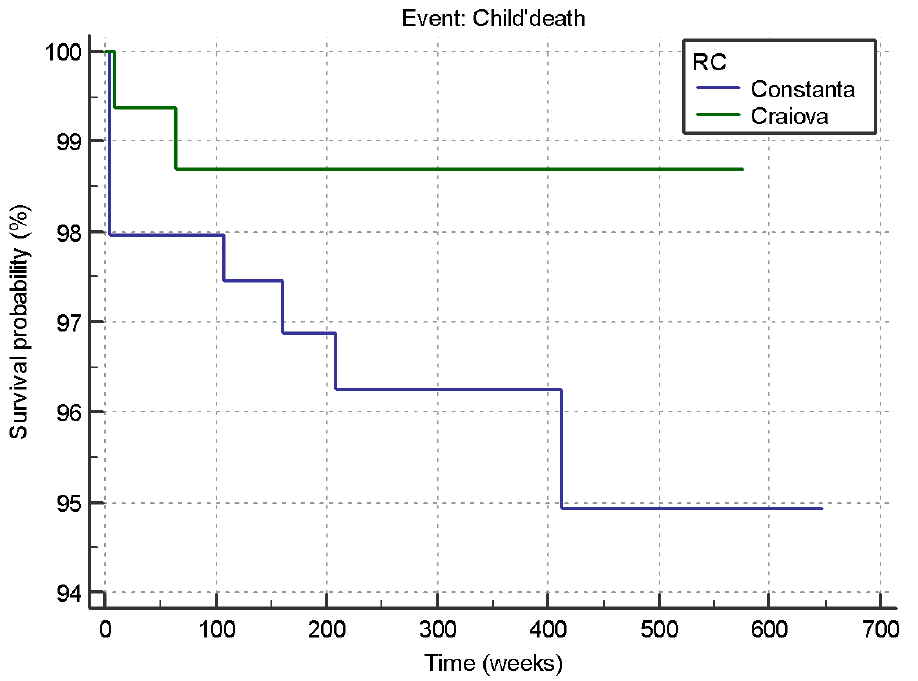
Figure 4. Survival curve of HIV-positive newborns for each RC.